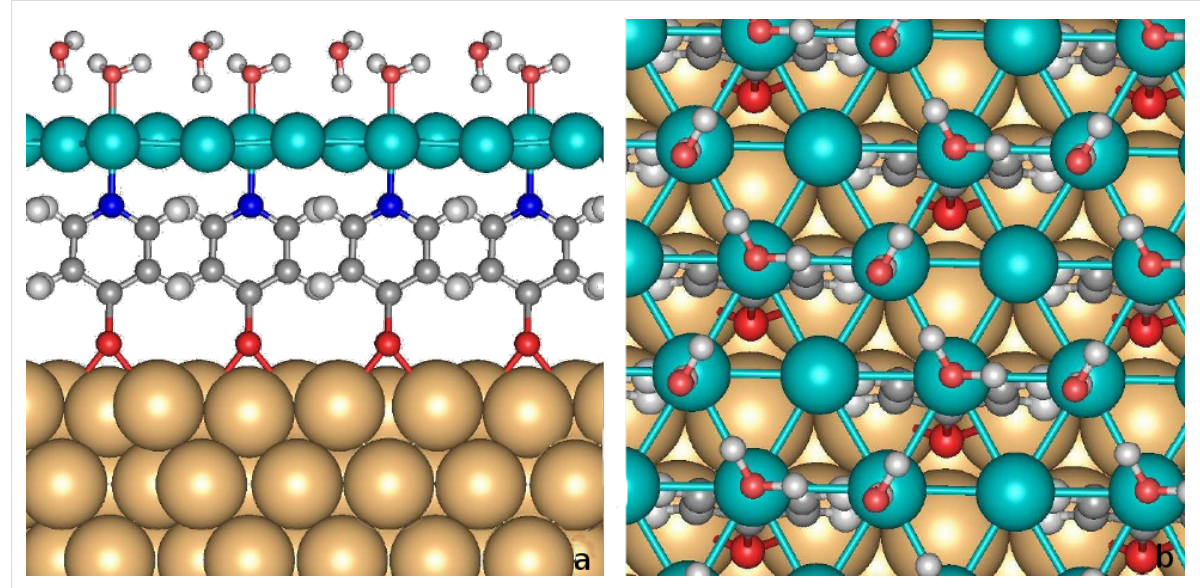
Figure 2: Side (a) and top (b) view of the optimized structure of water hexagonal bilayer on the palladium monolayer of ( )R30° Au/Mpy/Pd